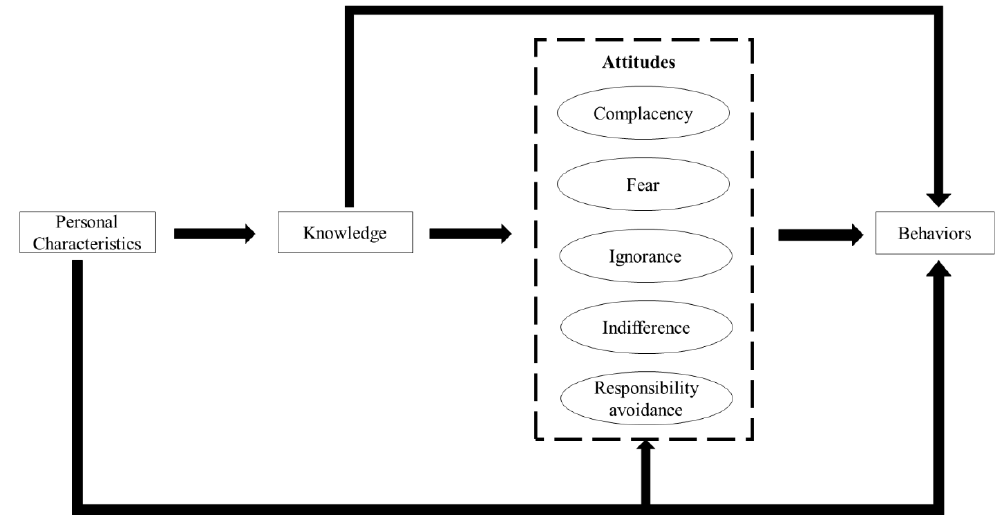
Figure 1. Theoretical framework of knowledge, attitudes, and behaviors in regard to antibiotic prescriptions.